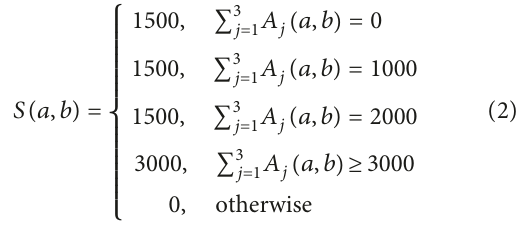
compares all the solutions k from objective f 3